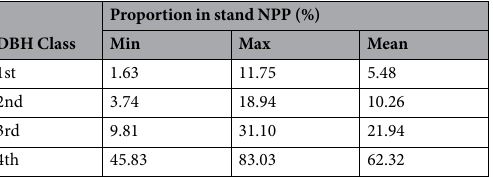
Table 3. Summed NPP (means across twenty years) for trees within each DBH class as a proportion of total stand NPP. Mean, min and max proportions for the 36 plots were reported here. In each plot, trees were grouped